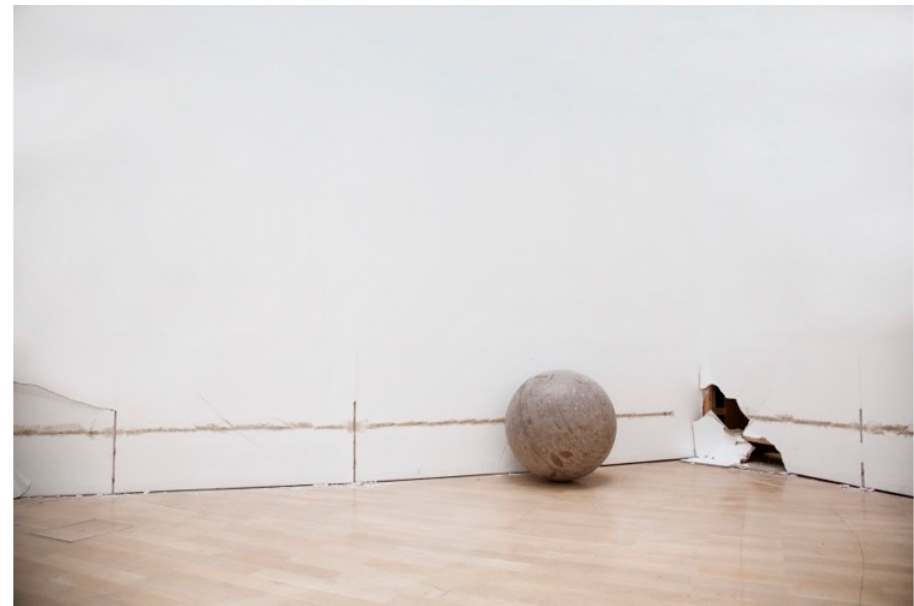
Figure 2. 360 ◦ Presence , Jeppe Hein, Kunstmuseum Wolfsburg, 2015. Photo: Mies